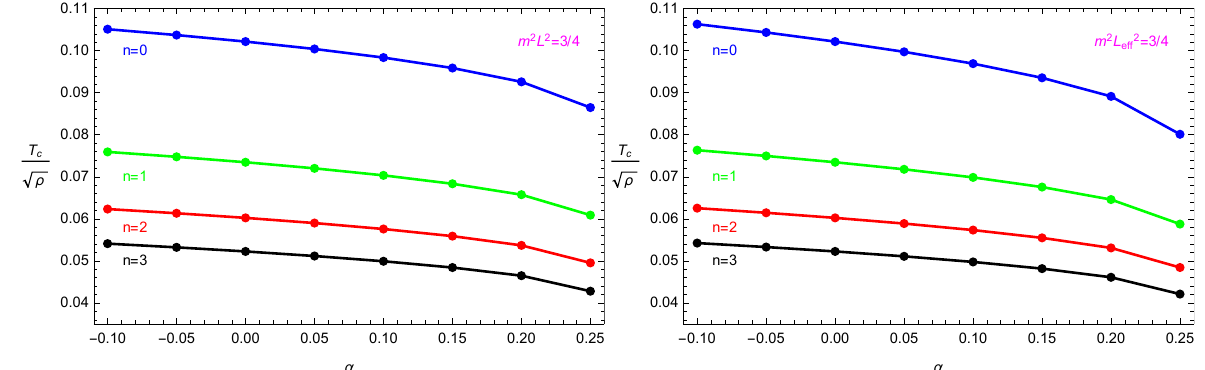
Figure 2. (Color online) The critical temperature T c of the vector operator O x as a function of the Gauss–Bonnet parameter for the fixed masses of the vector field m 2 L 2 = 3/4 ( left ) and m 2 L 2 ( right ) from the ground state to the third excited